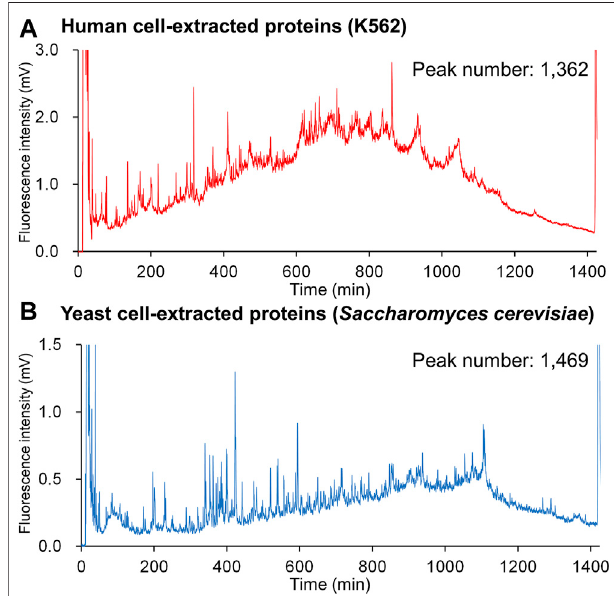
FIGURE 6 | Chromatograms for DAABD-derivatized (A) human cell – extracted proteins and (B) yeast cell – extracted proteins using the nano- fl ow FD-LC system.